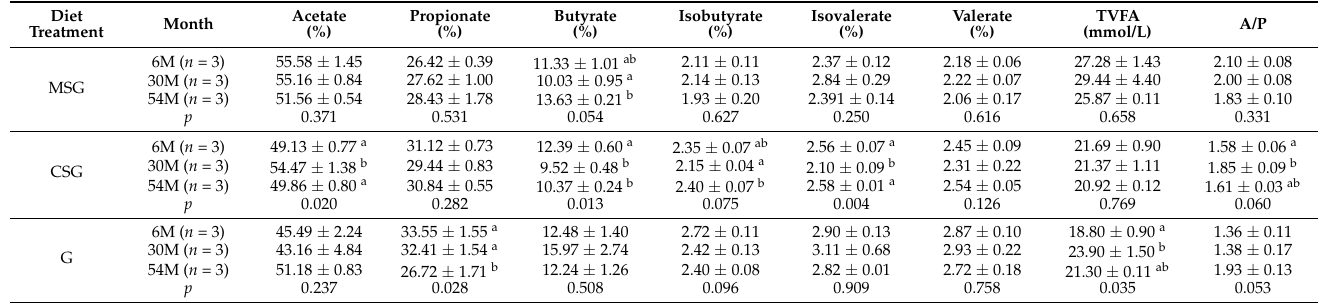
Table 7. The VFA level in the ruminal fluids of Tianzhu white yaks of different